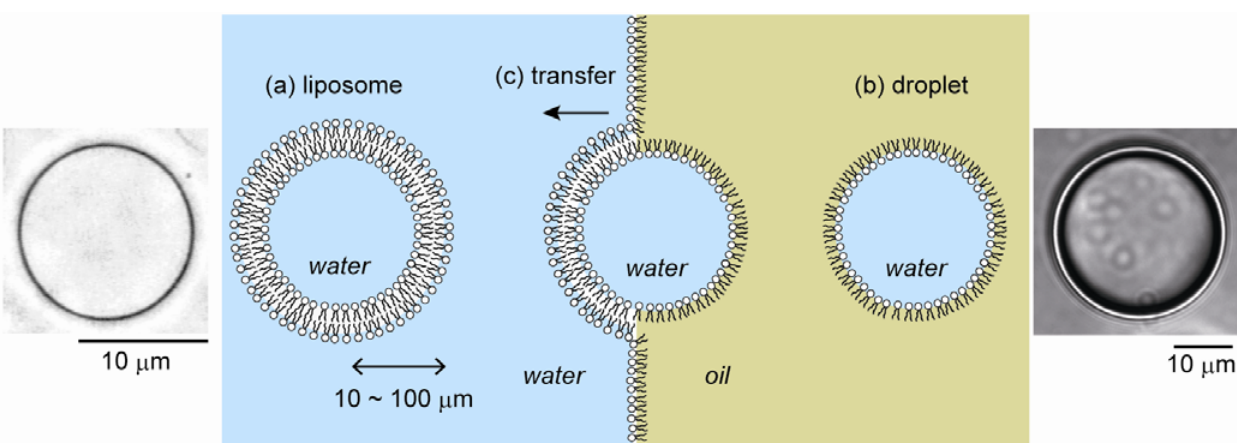
Figure 1. Schematic illustrations and typical microscopic images of cell-sized liposomes ( a ) and droplets ( b ). ( c ) Liposomes can be prepared by the transfer of droplets across an oil/water